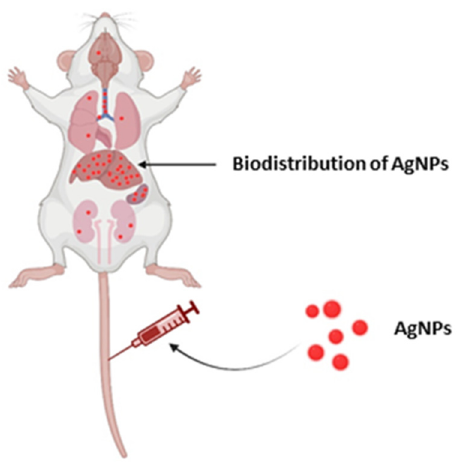
Figure 9. Biodistribution of AgNPs in rat organs.